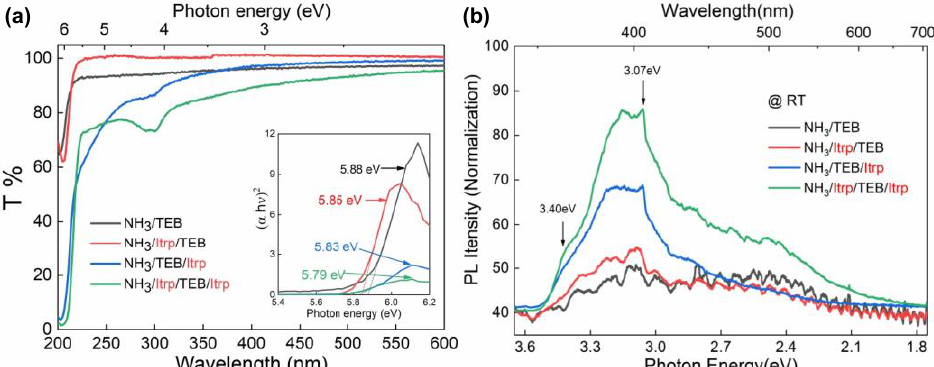
Figure 5. ( a ) The UV–vis transmission spectra and ( b ) normalized RT-PL spectra of the h-BN films with fixed 150 growth loops under four FME modes. The inset of ( a ) shows the (αhν) 2 versus photon energy hν for determining the optical bandgap energy of h -BN.